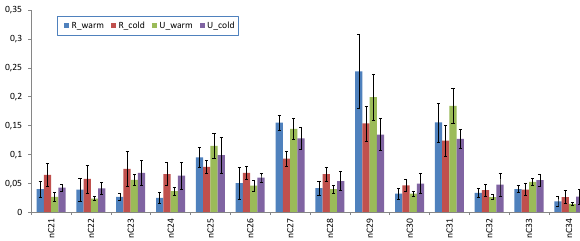
Figure 4. Relative composition of n-alkanes to P n-alkanes for the different period (warm vs. cold) in the rural (R) and urban (U)